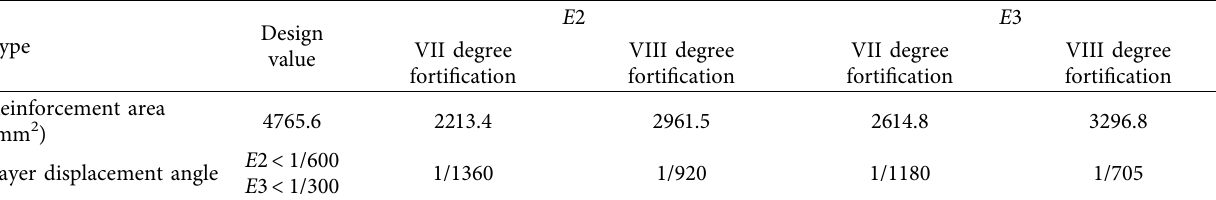
Table 4: Checking calculation results of section bearing capacity and